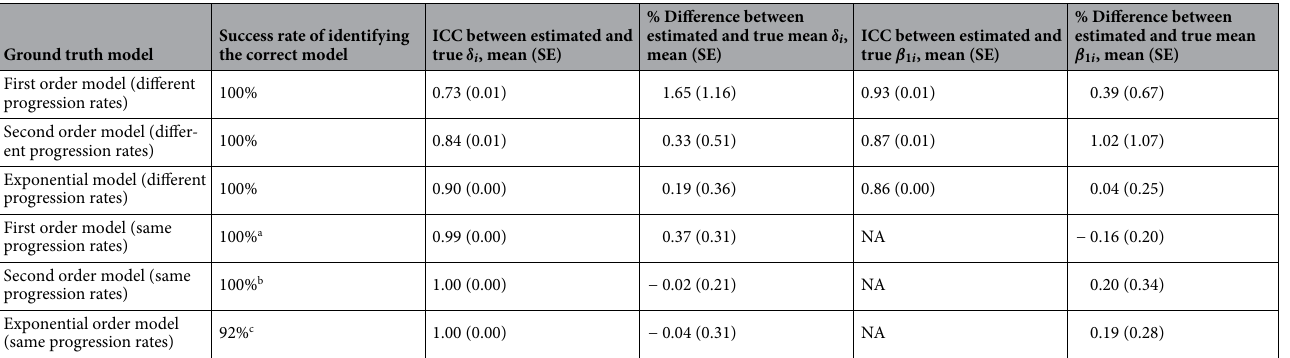
Table 1. Performance of Bayesian entry time realignment over 100 simulations. ICC intraclass correlation coefficient, NA not applicable, SE standard error, δ i baseline duration of disease, β 1i disease progression rate. a Over 100 simulations, the entry time realignment algorithm chose the first order model (different progression rates) in 33 simulations and the first order model (same progression rates) in 67 simulations. The mean (SE) of the difference in DIC between the 2 models is 1.07 (0.48). b Over 100 simulations, the entry time realignment algorithm chose the second order model (different progression rates) in 36 simulations and the second order model (same progression rates) in 64 simulations. The mean (SE) of the difference in DIC between the 2 models is 0.48 (0.36). C Over 100 simulations, the entry time realignment algorithm chose the exponential model (different progression rates) in 37 simulations and the exponential model (same progression rates) in 55 simulations. In 8 simulations, the second order model (different progression rates) resulted in the lowest DIC. The mean (SE) of the difference in DIC between the exponential model (different progression rates) and the exponential model (same progression rates) is − 0.070